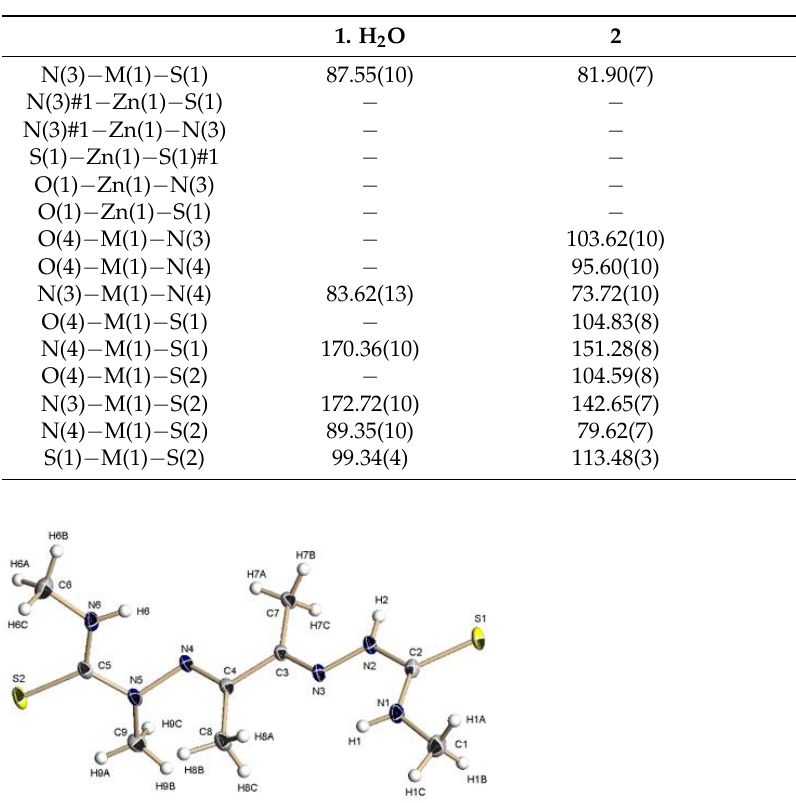
Figure 1. Molecular structure of HMeATSM. Thermal ellipsoids at 50% probability level. Figure 2 represents the molecular structure of complex 1. It crystallizes with a water molecule in the monoclinic P2(1)/n space group. The asymmetric unit contains a single [Ni(MeATSM)] + cation, a nitrate group as counterion and a water molecule of crystallization. The nickel(II) ion is coordinated to a N 2 S 2 tetradentate anionic ligand. The pseudomacrocyclic coordination mode of the ligand affords three five-member chelate rings that confer high stability to the complex. The value of the τ 4 parameter is 0.12, which indicates a square planar geometry for the metal ( τ 4 = 1 for tetrahedral geometry and τ 4 = 0 for square planar [43]). This is in agreement with the magnetic susceptibility measurement, which indicates the complex is diamagnetic. Bond lengths shows a considerable electronic delocalization through the thiosemicarbazone backbone, which is enhanced upon ligand deprotonation. Thus, both thione bond distances are longer than in the free ligand, with the greater change observed in the 4-methyl-3-thiosemicarbazone branch which is deprotonated. The different behavior of the two arms are reflected on the values of 1.294(5) and 1.301(5) Å for the N(3)–C(3) and N(4)–C(4) with respect to the free ligand [1.288(2)]. In addition, the bond N(2)–N(3) is longer, but N(4)–N(5) is shorter than in the free ligand. The ligand is almost planar with a maximum deviation from the least-squares-planes of 0.12 Å for C(4). Bond lengths involving the Ni(II) ion have similar values than other nickel complexes with thiosemicarbazone ligands [9,44]. There is an extended network of inter- molecular hydrogen bonds involving both amino groups, the NO 3- and the water molecule leading to a 3D